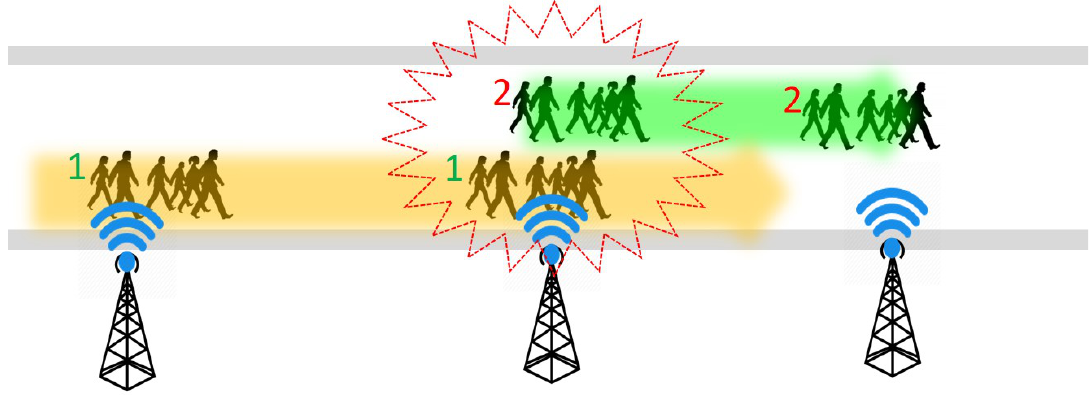
Figure 7. Group speed detection